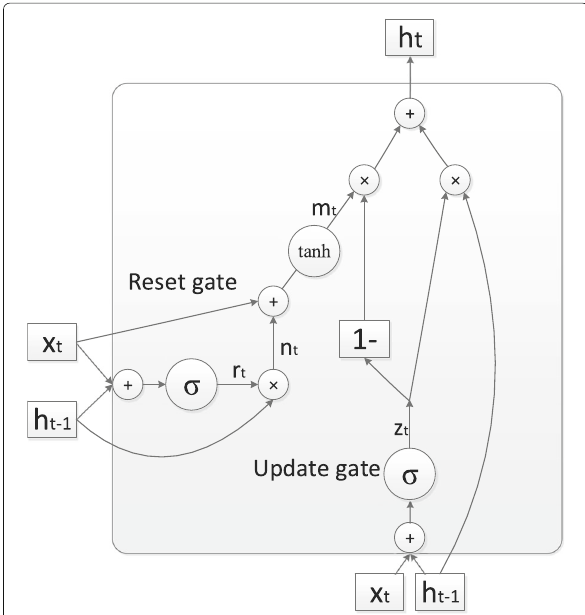
Fig. 3 Gated recurrent unit. σ denotes the sigmoid function, “tanh” denotes hyperbolic tangent